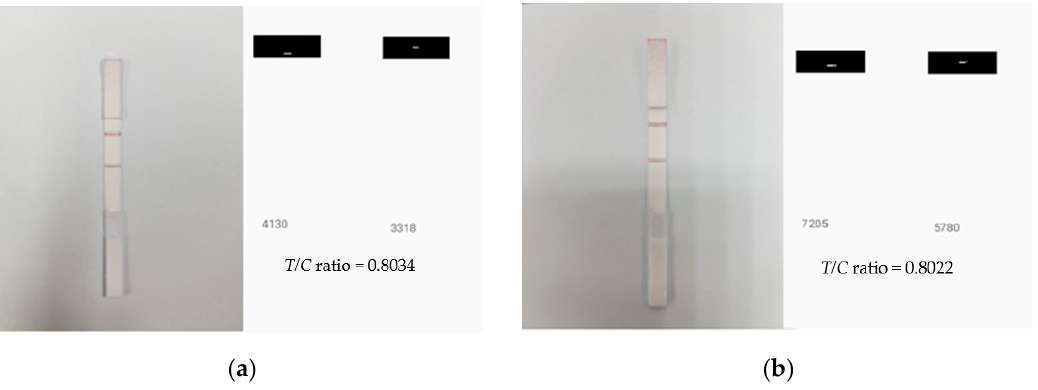
Figure 9. LFA strip and calculated T/C ratio for two different lighting conditions: ( a ) 36-Watt LED ceiling lamp and ( b ) 27-Watt LED table lamp illuminated environments, showing a similar T/C ratio.